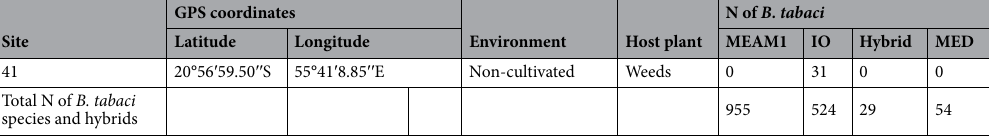
Table 1. B. tabaci sampling in La Réunion: location of collection site, environment, host plant and number (N) of species and hybrids found. Weeds: Mexican fireplant Euphorbia heterophylla L. (Euphorbiaceae), bean Vigna sp. L. (Fabaceae), lantana Lantana camara L. (Verbenaceae), pricklyburr Datura innoxia Mill. (Solanaceae), turpeth Operculina turpethum (Convolvulaceae), cotton Gossypium sp. (Malvaceae); crops: tomato Solanum lycopersicum L. (Solanaceae), eggplant Solanum melongena L. (Solanaceae), cucumber cucumis sativus L. (Cucurbitaceae), melon Cucumis melo L. (Cucurbitaceae). NA not available. a Host plants are tomato and eggplant crops. b Sugarcane field without any insecticide